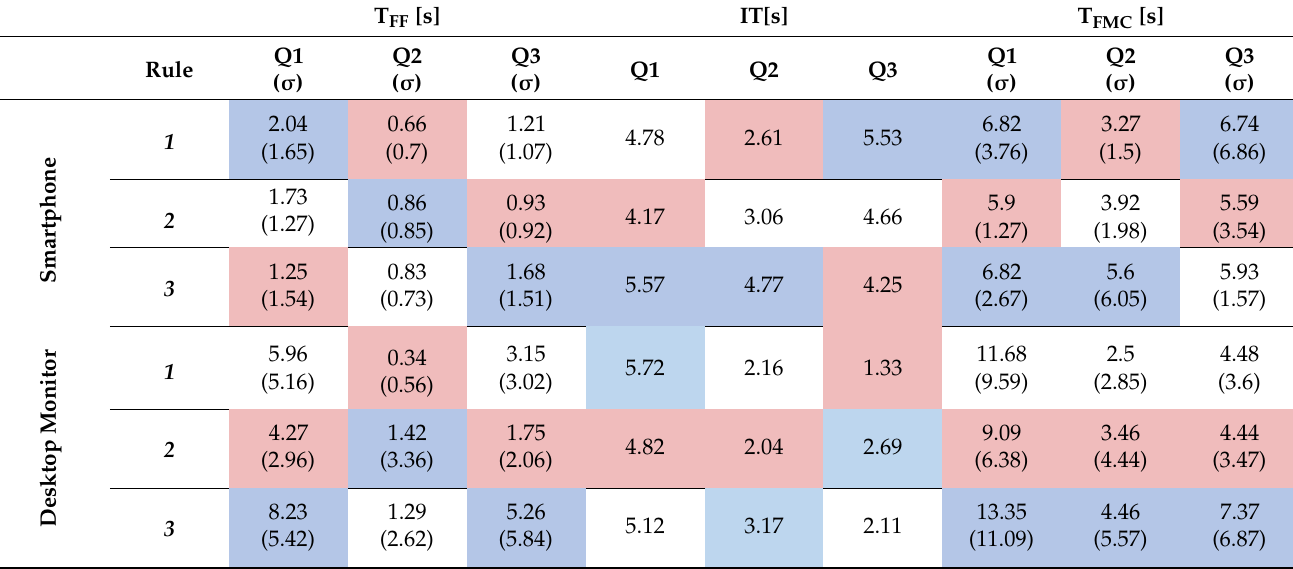
Table 1. The average time to first fixation (T FF ), identification time (IT), and time to first mouse click (T FMC ) for individual tasks and button layout variants in GUI as suggested on the basis of three rules (Rule 1—Design from smaller to larger device; Rule 2—Design from larger to smaller device; Rule 3—Two different designs).